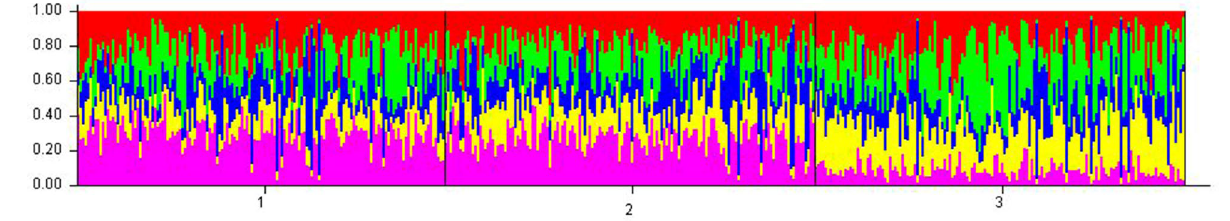
Figure 4. Summary barplot of estimated membership coefficients. Every single vertical line represents one Norway spruce individual in K-colored segments (K = 5) where 1, 2, and 3 represent the LE, ME, and HE ecotypic groups, respectively.